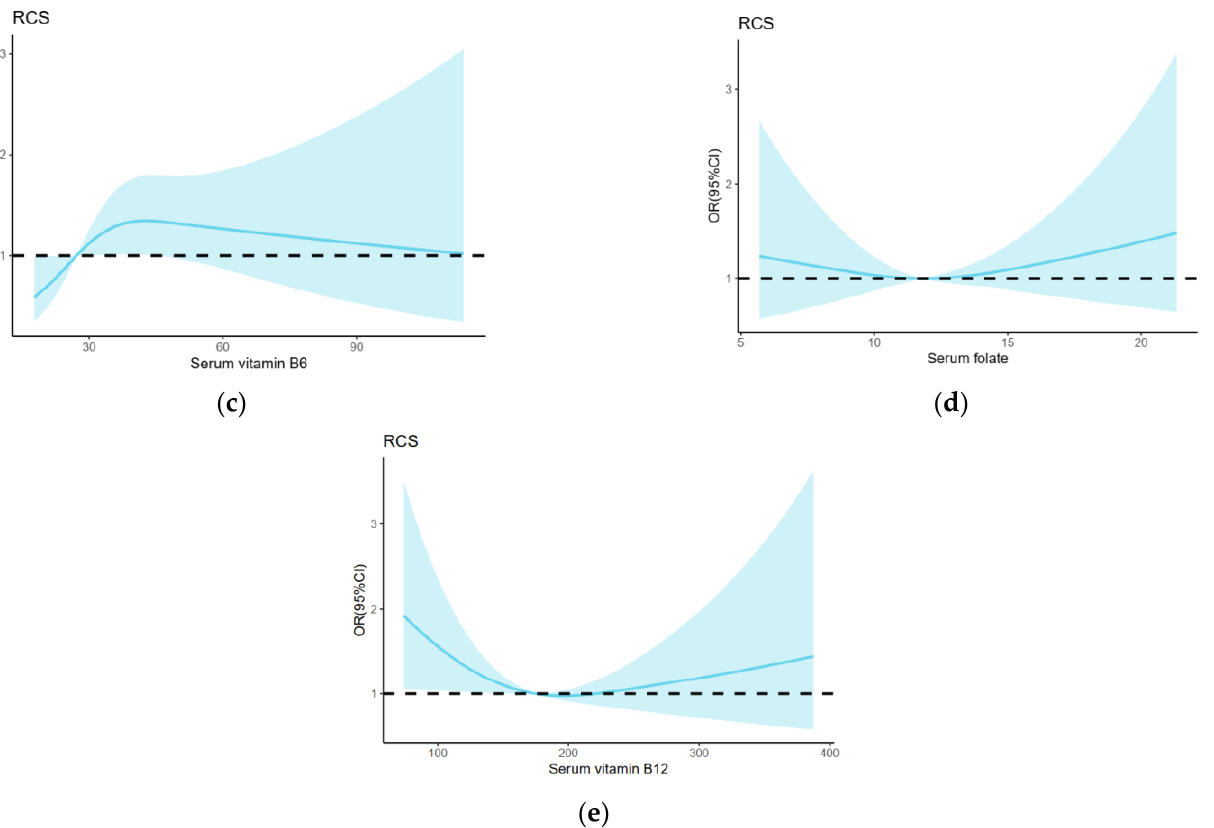
Figure 2. Restricted cubic spline (RCS) regression analysis of group B vitamins including ( a ) serum vitamin B 1 , ( b ) serum vitamin B 2 , ( c ) serum vitamin B 6 , ( d ) serum folate, and ( e ) serum vitamin B 12 with GDM risk. The median of vitamin B 1 86.5 pmol/L, B 2 13.5 pmol/L, B 6 27.2 pmol/L, folate 11.8 nmol/L and B 12 174.8 pmol/L was selected as the reference levels, respectively. The lines indicate estimated ORs, and the light-blue–shaded areas represent 95%CI.